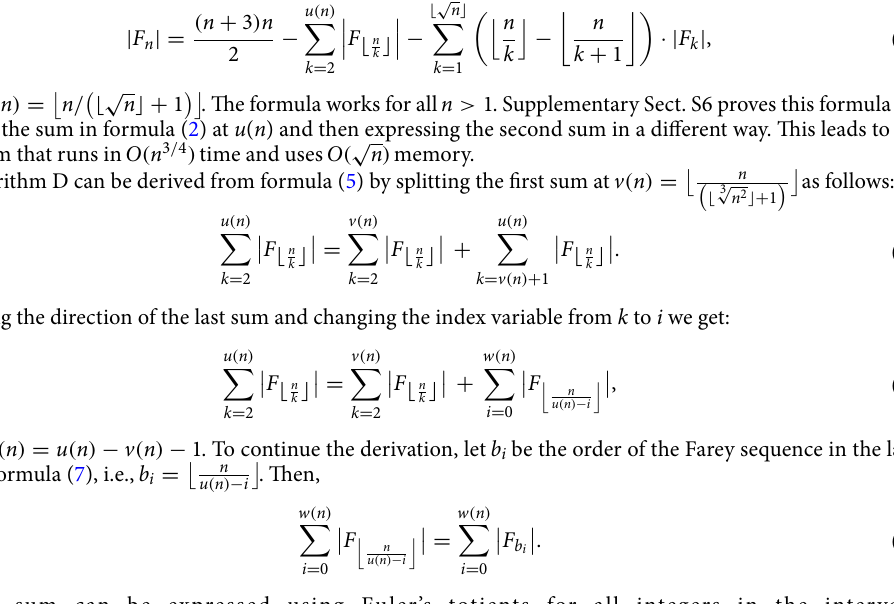
Algorithm C is based on the following novel formula for the length of F n